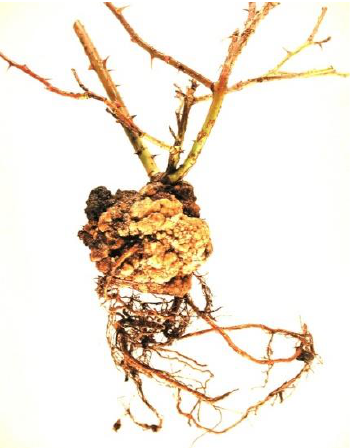
Figure 1. Crown gall on rose (provided by Melodie Putnam).